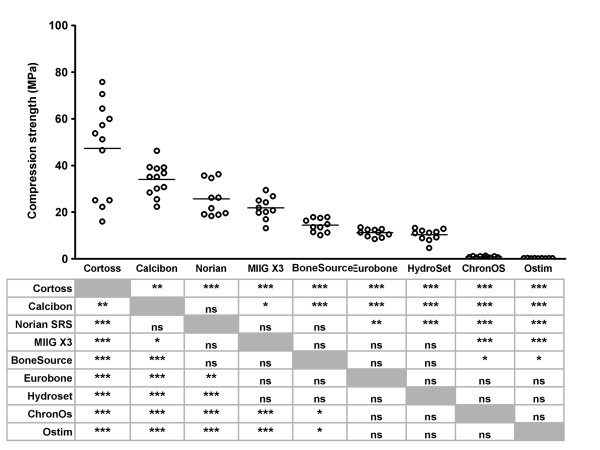
Compression strength of bone substitutes The compression strength was determined using unconfined compression tests as described in the Materials and Methods. Each dot represents an individual test sample, and lines indicate the average value. The table below the figure shows the outcome of the pairwise comparisons (Student's T-test with Bonferroni correction). *, p < 0.05; **, p < 0.01; ***, p < 0.005; ns, not statistically significantly different. Grey boxes represent the self-self combinations, which could not be tested.